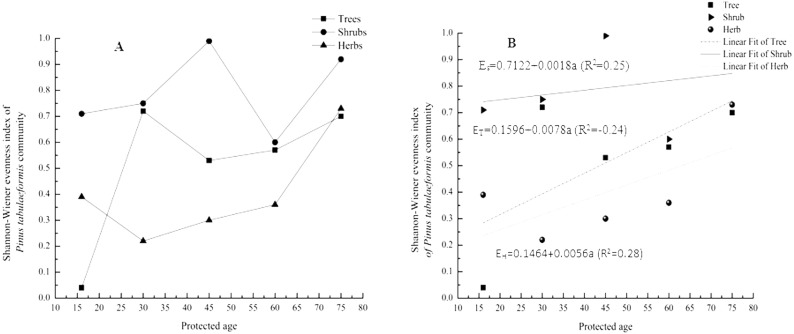
Shannon–Wiener evenness index of Pinus tabulaeformis community in protected stands.Letters ET, ES, EH and a in Fig. 4B stand for the evenness index of tree, shrub, herb and protection year respectively. Confidence interval of 95% for evenness of tress, shrubs and herbs is [0.16, 0.85], [0.60, 0.99] and [0.16, 0.64] respectively. Equations in Fig. 4B show the relationship between evenness index and protected year of stands. ET, Es, EH show a represented evenness index of tree, shrub, herb and protected year of stands, respectively.